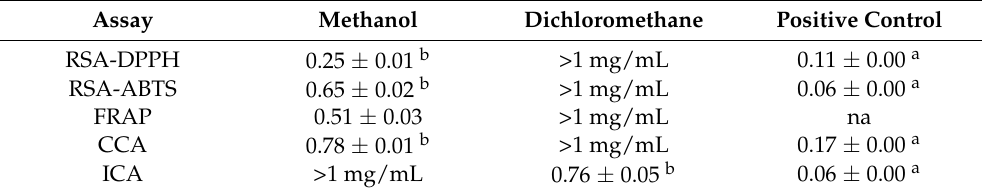
Table 2. Antioxidant activities of the methanol and dichloromethane extracts of sea heath’s ( F. laevis ) aboveground biomass. The results are expressed as half-maximal effective concentration (EC 50 ) values (mg/mL).